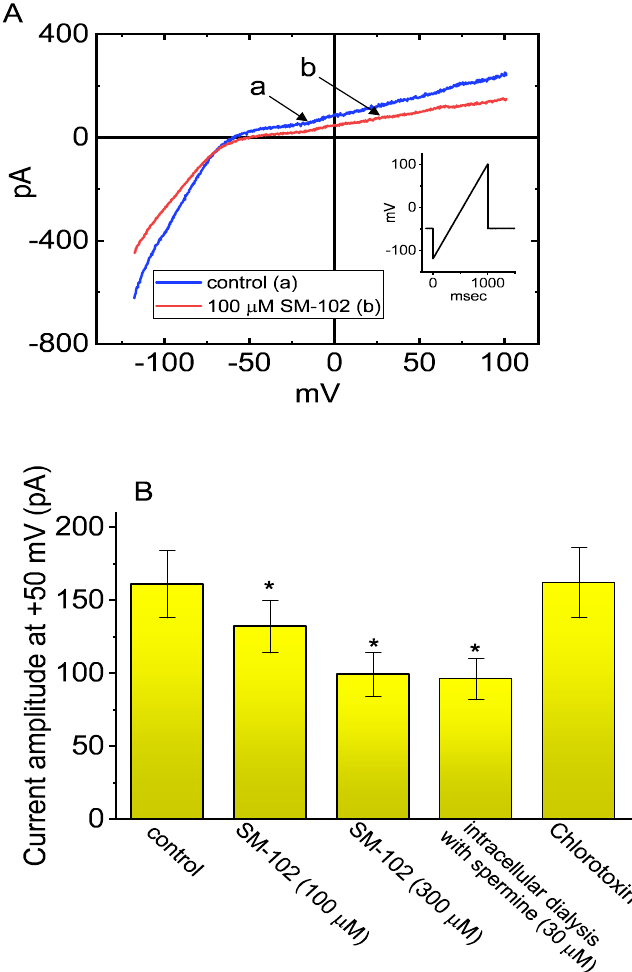
Figure 7. Effect of SM-102 on the inwardly rectifying K + current (I K(IR) ) in BV2 microglial cells. In this set of experiments, a holding potential was maintained at − 50 mV and an upsloping ramp pulse from − 120 to +100 mV with a duration of 1 s was applied to the cell examined. ( A ) Representative current traces obtained in the absence (a) or presence (b) of 100 µ M SM-102. Inset shows the voltage protocol used. ( B ) Summary bar graph showing effect of SM-102, intracellular dialysis with spermine, or chlorotoxin on I K(IR) amplitude activated by ramp pulse (mean ± SEM; n = 7 for each bar). Each current amplitude was measured at the level of +50 mV. Data analysis was performed by ANOVA-1 ( p < 0.05). * Significantly different from control ( p < 0.05).